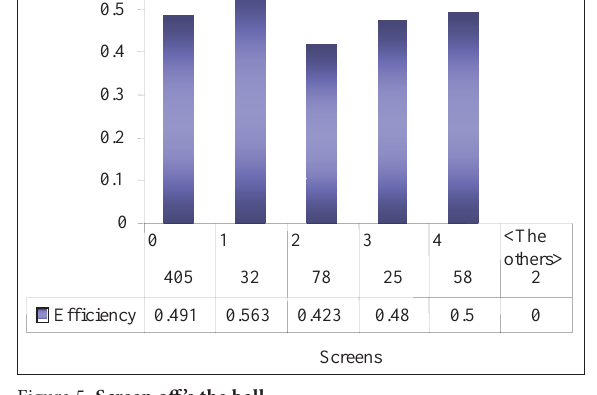
Figure 5. Screen off ’s the ball